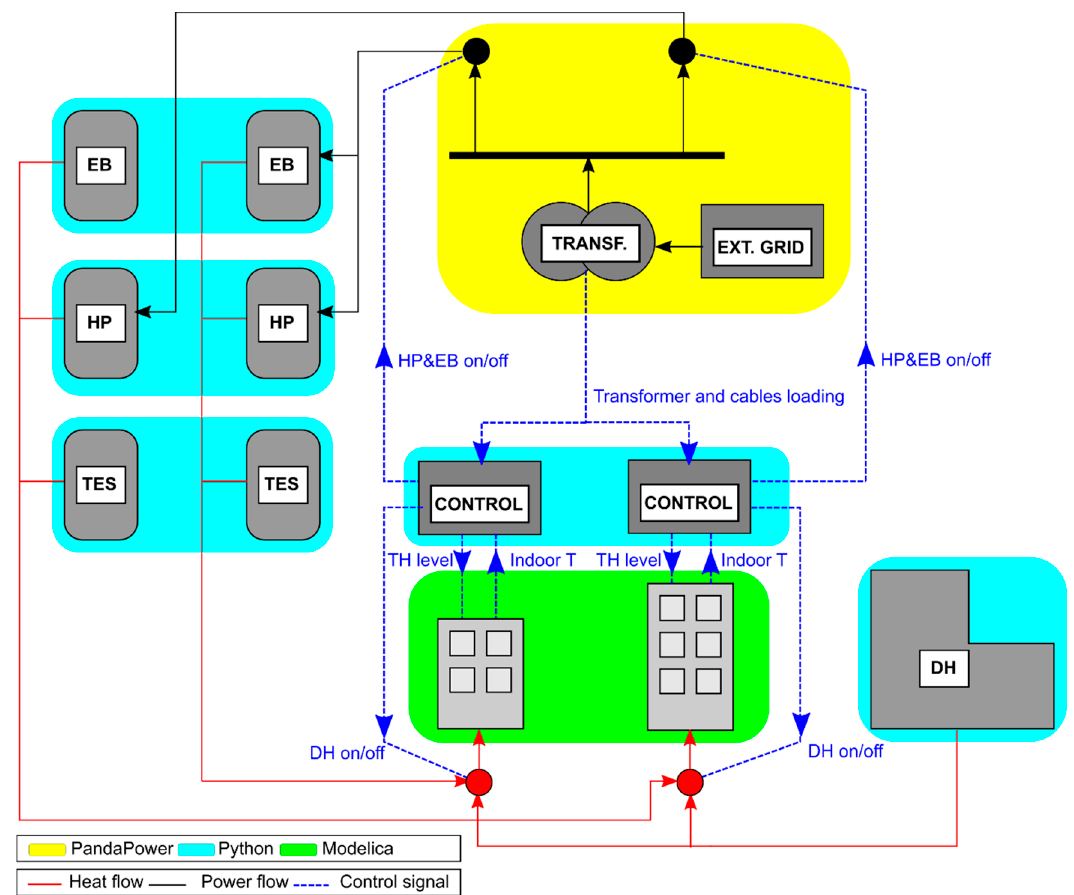
Figure 3. Co-simulation scheme for the reference scenario (EB: electrical backup; TH: